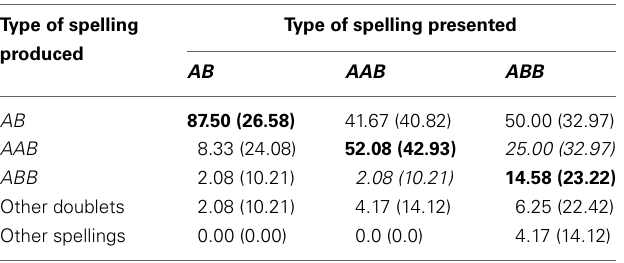
Table 3 | Percentages of AB, AAB, and ABB spellings produced in Experiment 2 as a function of type of spelling